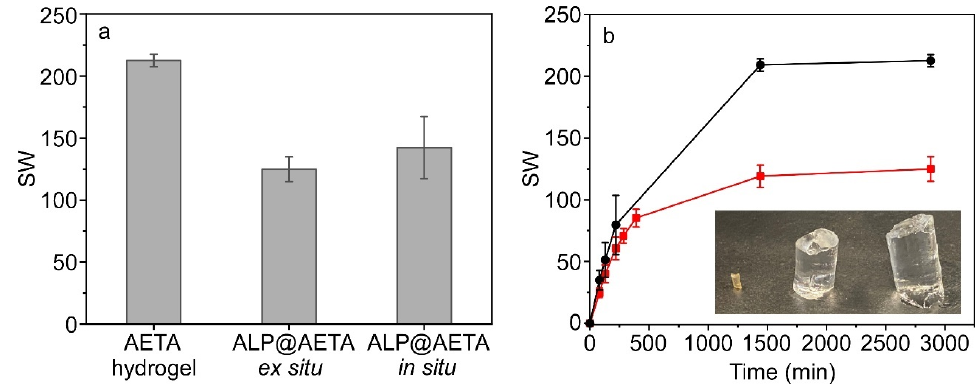
Figure 1. ( a ) Maximum swelling degree of AETA hydrogel, ALP@AETA ex situ and ALP@AETA in situ hydrogels (20 µM of protein). ( b ) Swelling behavior of AETA (black) and ALP@AETA ex situ hydrogel (red). Inset: Digital image of the dried hydrogel (left), the fully swollen ALP@AETA ex situ (center) and AETA (right) hydrogels. Error bars stand for the standard deviation of three replicates.